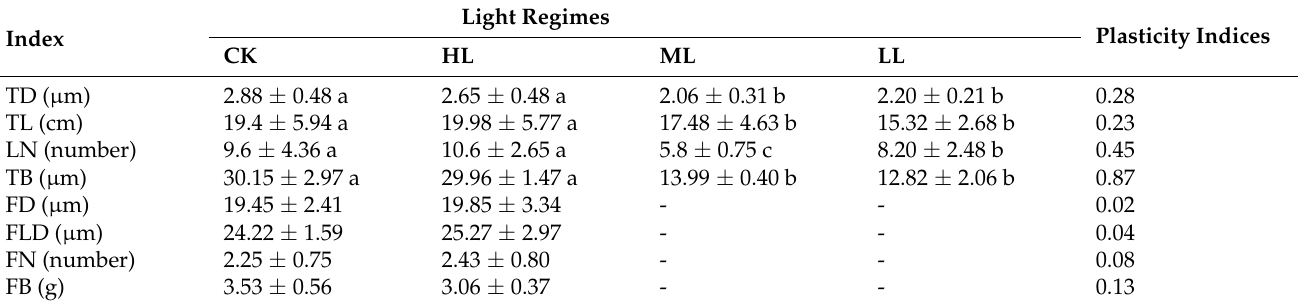
Table 5. Morphology and biomass of C. oleifera twigs under different light regimes.